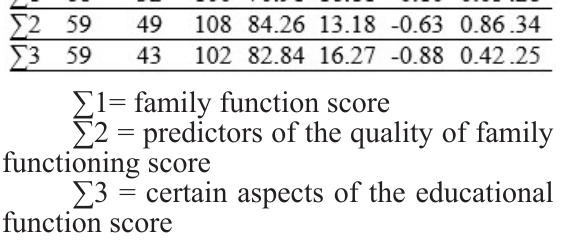
Table 5. Hypothesis Test Summary (Independent Samples Mann-Whitney U Test)